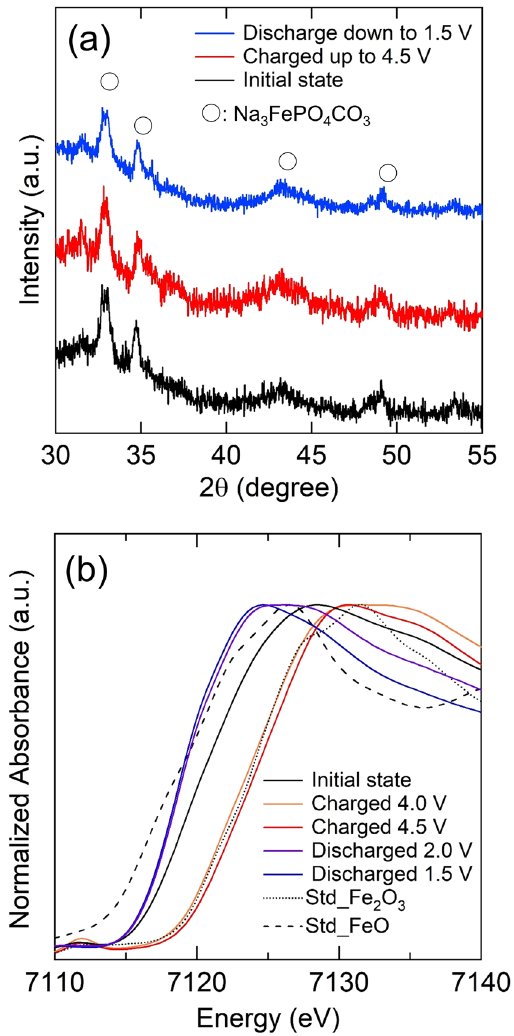
Figure 3. Ex-situ XRD patterns of MM_NFPC/C at different states during the first cycle between 1.5 and 4.5 V at 0.2 mA/cm 2 at room temperature ( a ); ex-situ XANES spectra of MM_NFPC/C at different states during the first cycle between 1.5 and 4.5 V at 0.2 mA/cm 2 at room temperature ( b